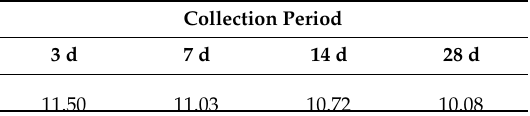
Table 6. pH of the solution at the time of sampling ( LTT2 ).